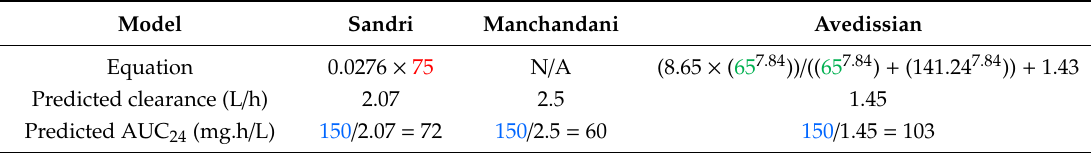
Table A1. An example of polymyxin B area under the curve (AUC) prediction by di ff erent models. Model